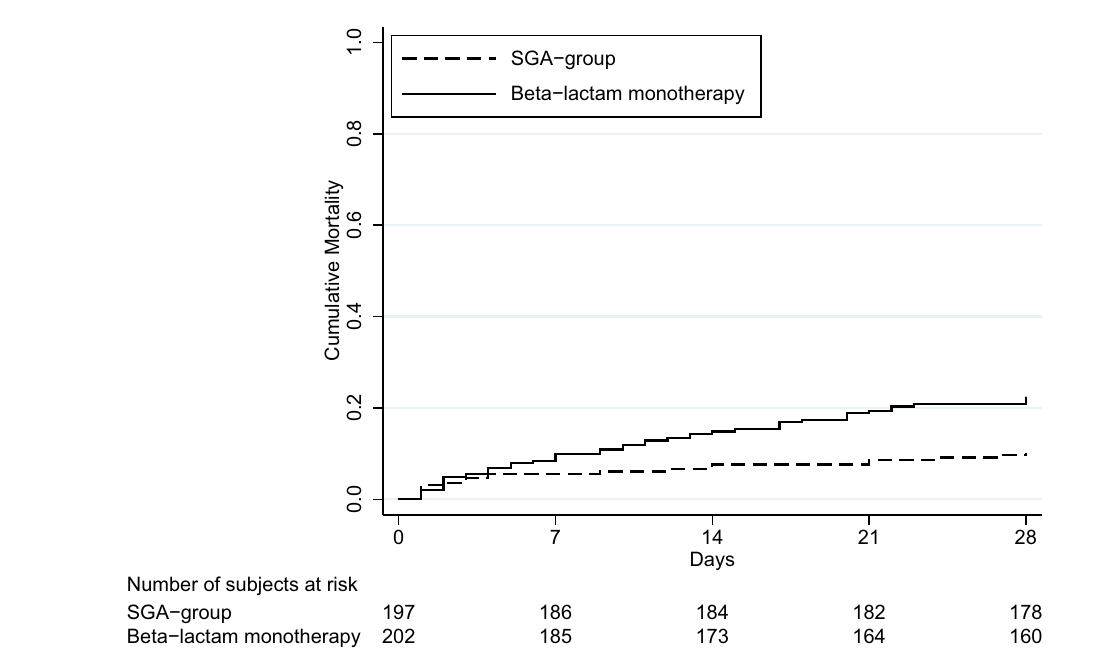
Fig 2. Kaplan Meier curve illustrating the significant difference in mortality between the monotherapy group (22%, 45/202) and SGA (10%, 20/197).